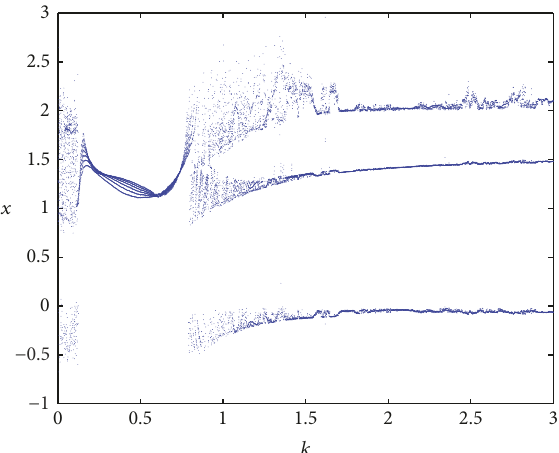
Figure 1: Bifurcation diagram of the system (1) with initial condi- tions (1,2,0.5, 0.5) versus parameter 𝑘